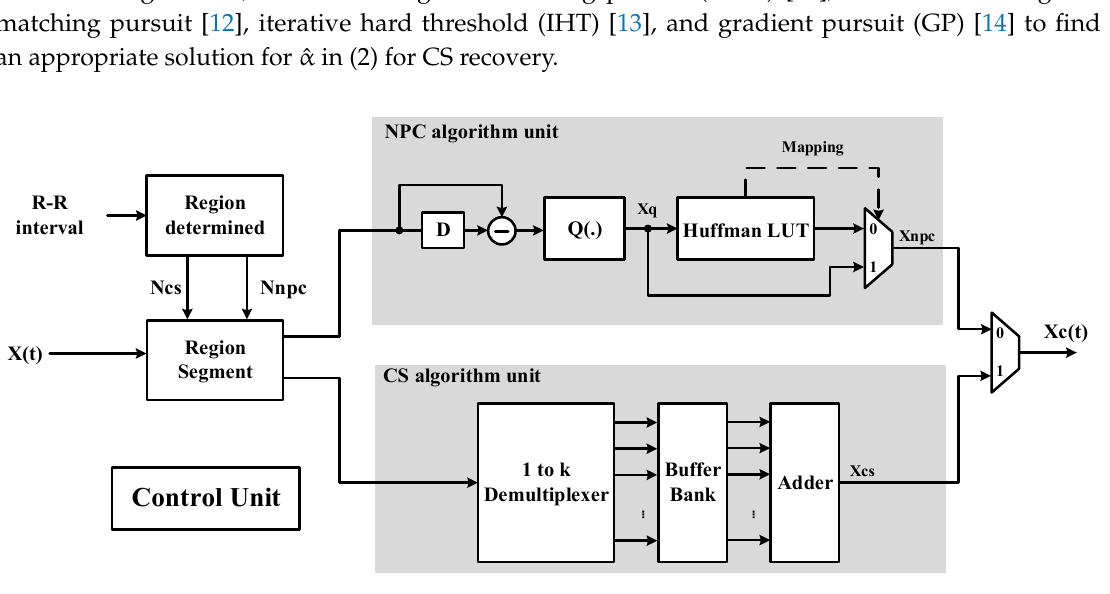
Figure 2. Proposed architecture. NPC: near-precise compressed.